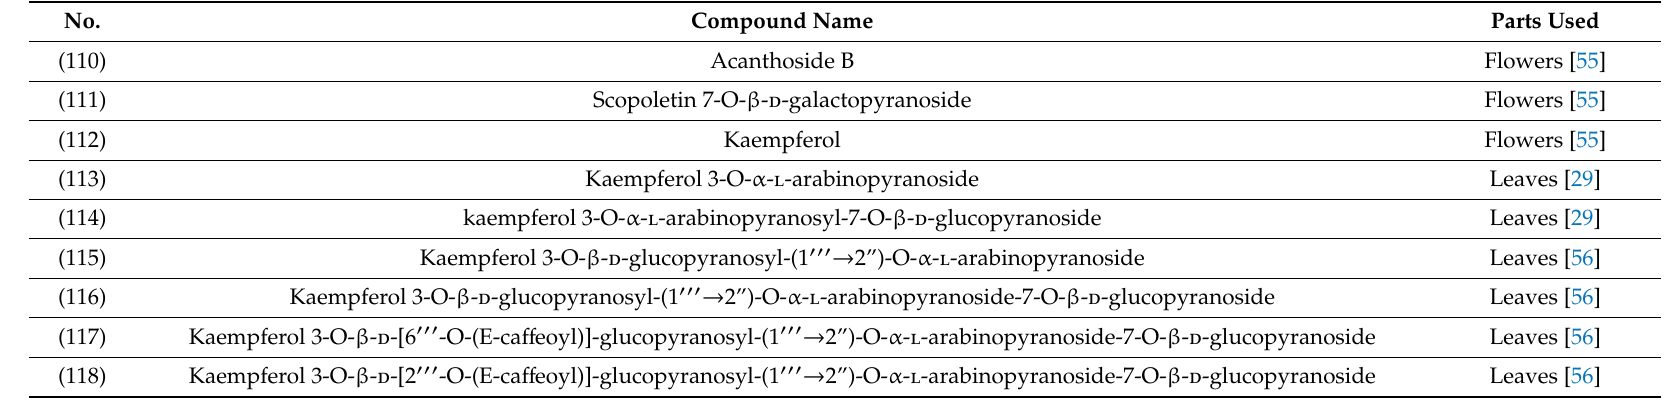
Table 4. Phenolic Compounds, Coumarin, and Flavonoids from Brugmansia suaveolens .